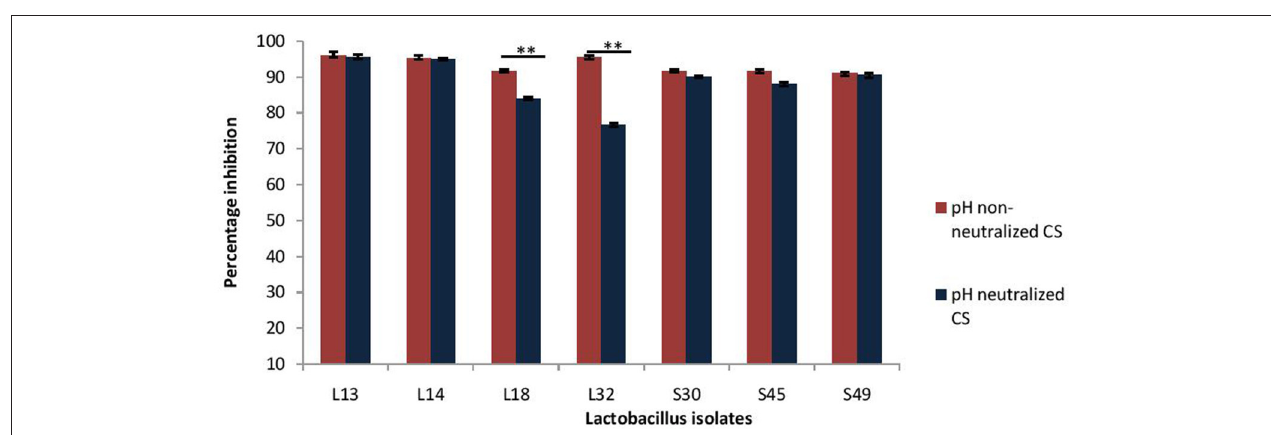
FIGURE 3 | Percentage inhibition of biofilm formation of V. cholerae by pH neutralized and non-neutralized CS of fecal Lactobacillus isolates evaluated by modified crystal violet assay performed in a microtiter plate. Bars are representative of the mean and error bars are representative of standard deviation of three independent experiments. **Significance ( p < 0.0001) was measured by using an unpaired Student’s t -test.